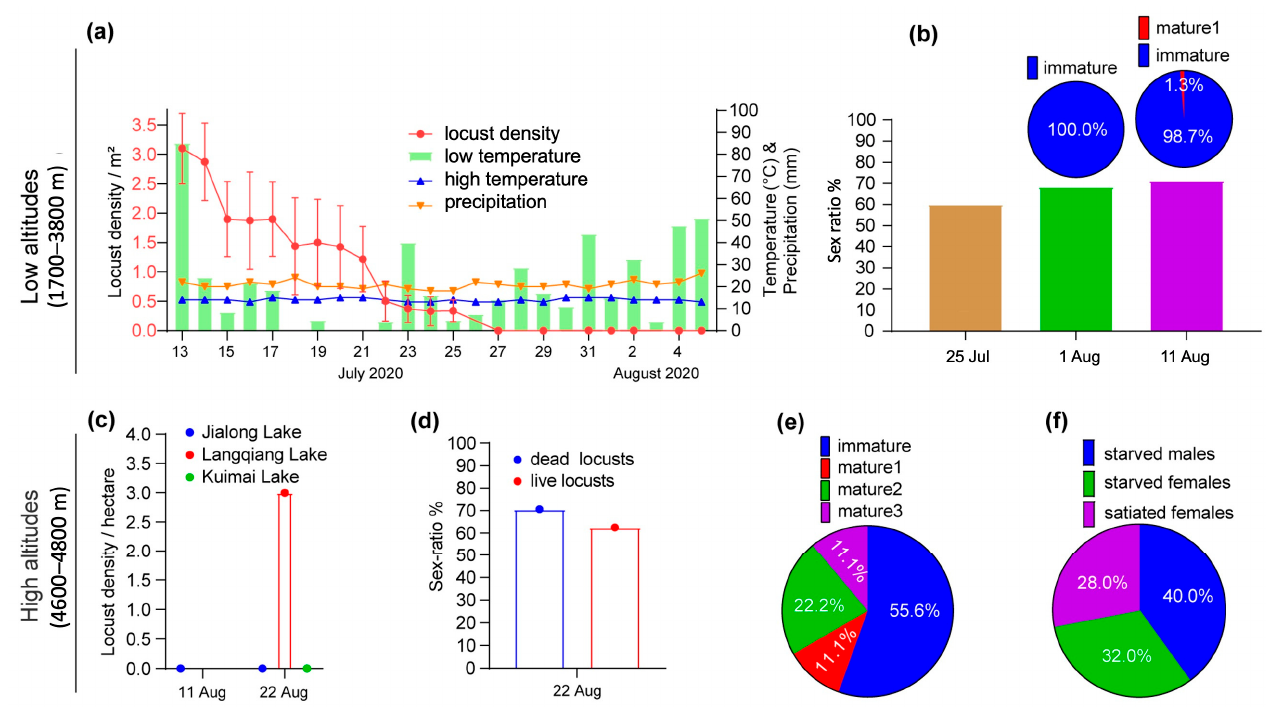
Figure 3. Desert locust field monitoring in low and high altitudes in Nyalam County, Tibet, in July–August 2020. Lower altitudes: changes in locust average density as a function of temperature and rainfall ( a ), locust sex ratio and ovarian development ( b ). Higher altitudes: locust density at three sites ( c ), sex ratio ( d ), ovarian development ( e ). Filling degree of the digestive tract of locusts collected in the field ( f ).